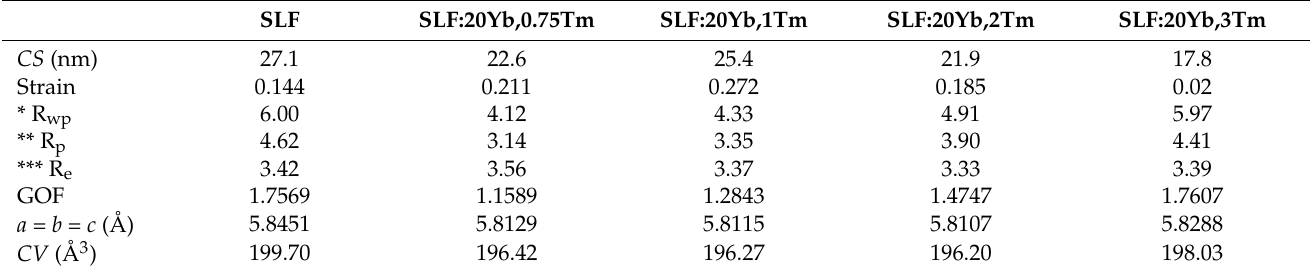
Table 2. Results of the structural analysis by using WPF refinement of SLF:20 mol%Yb 3+ ,yTm 3+